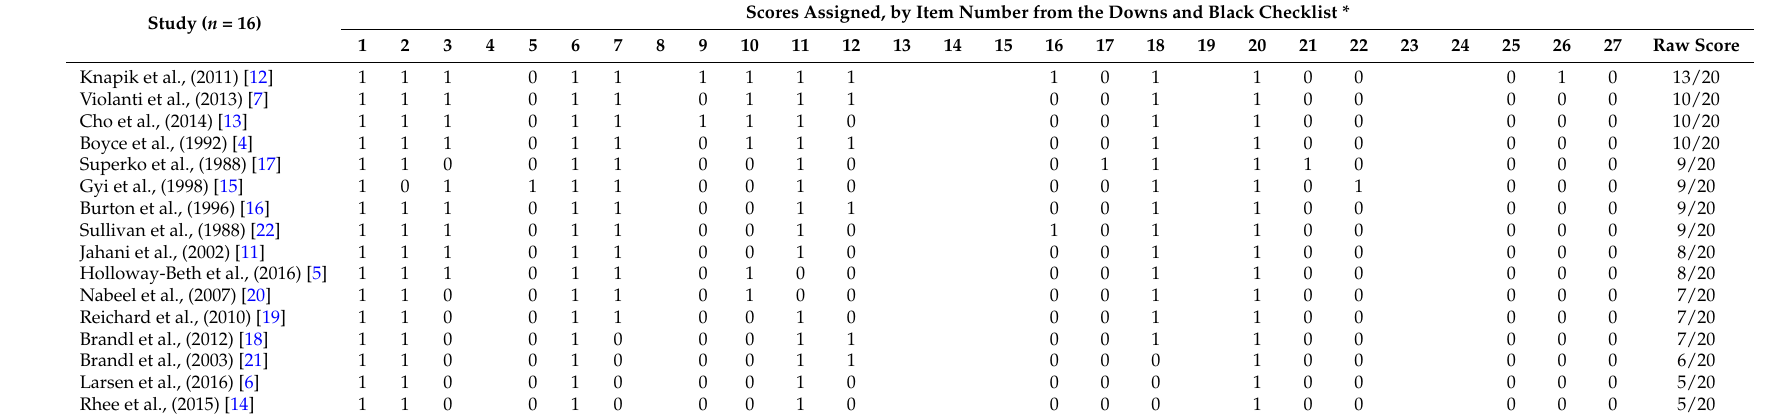
Table A1. Downs and Black [24] Critical Appraisal results for all included